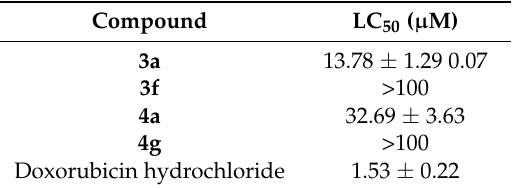
Table 2. Cytotoxic effects of 3a , 3f , 4a and 4g against Monkey kidney Vero cell